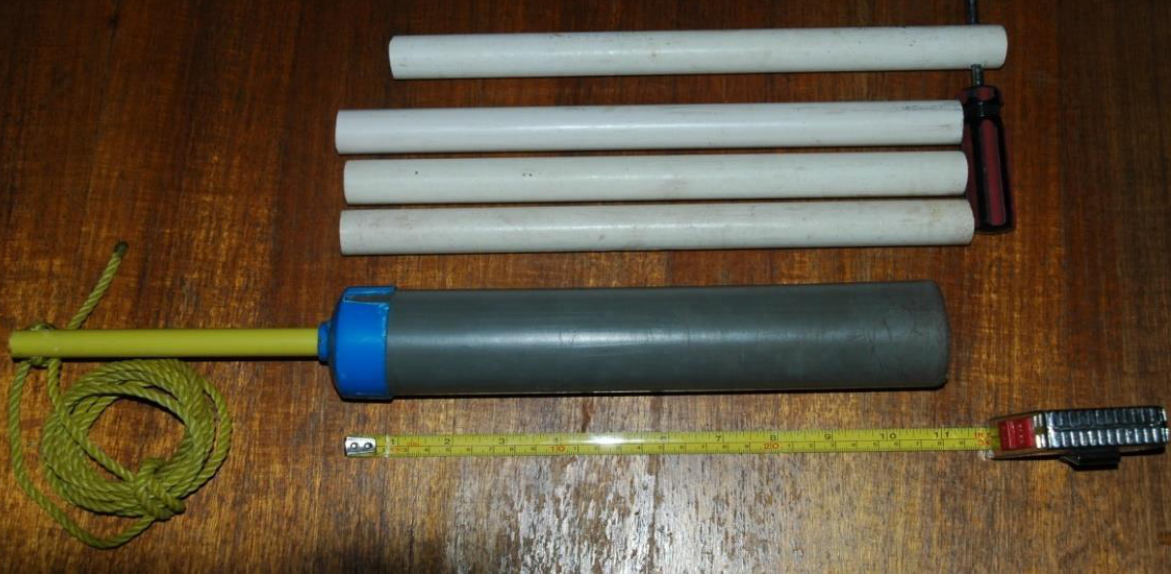
Figure 3. Corer used for sampling smaller and softer aestivation site